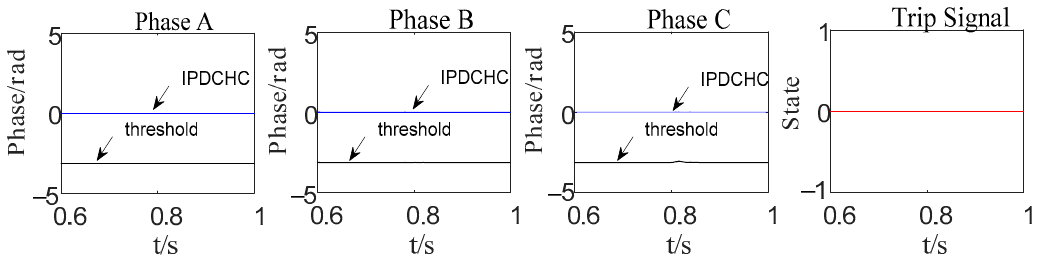
Figure 10. Simulation result of non-fault disturbance situation.